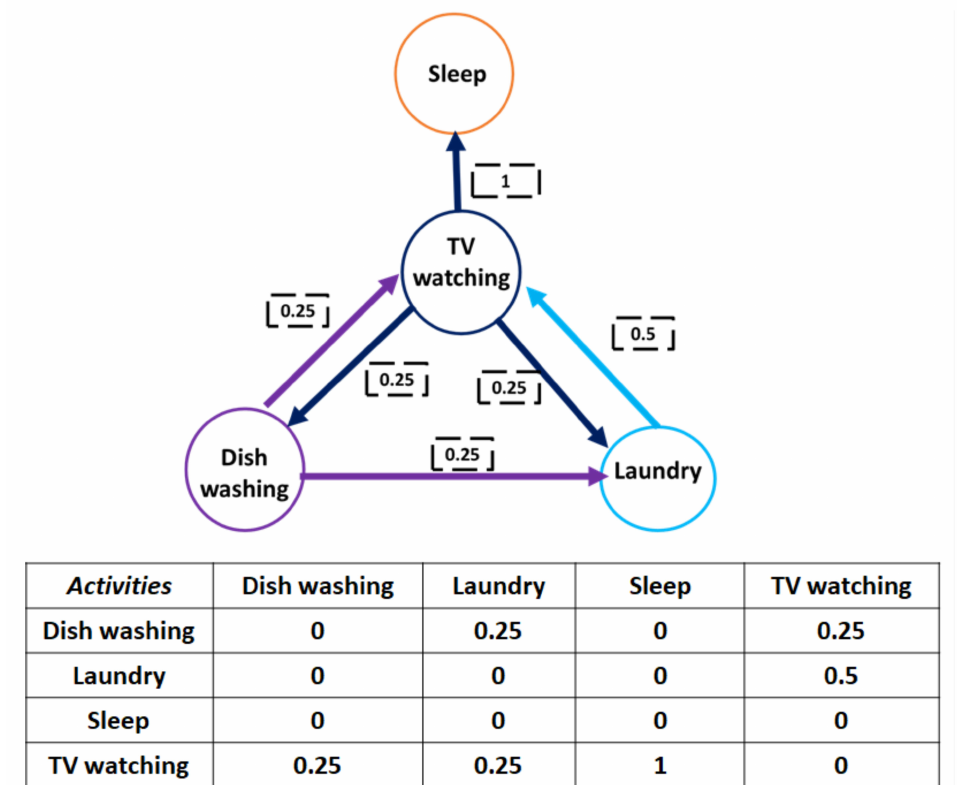
Figure 4. Graphical representation of transitions between activity